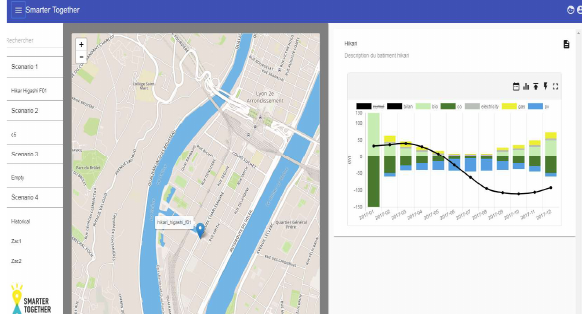
Figure 17. Community Management System Version 2: Energy Visualisation and analysis tool at the Confluence of the